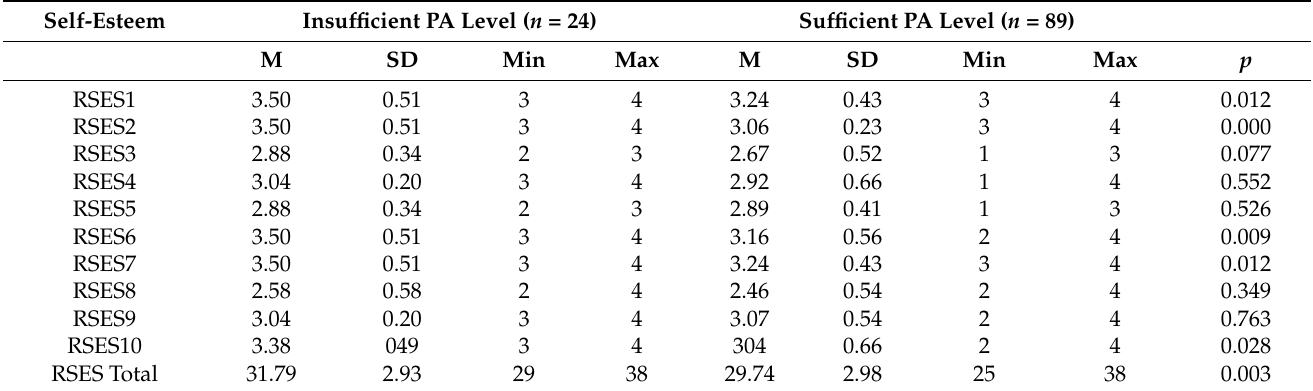
Table 4. Characteristics of self-esteem according to RSES according to physical activity level.